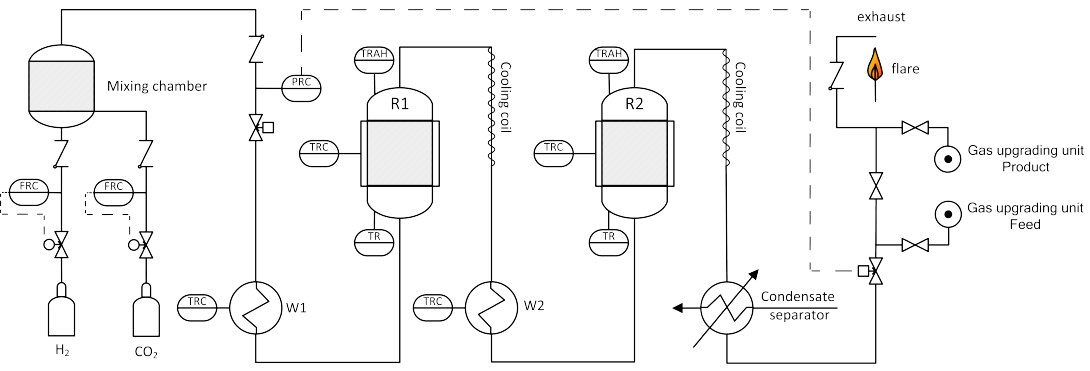
Figure 9. Simplified flow sheet of the lab scaled methanation plant.